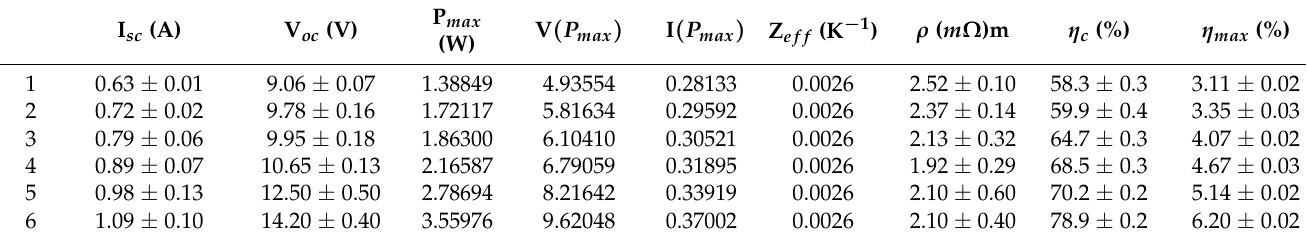
Table 3. Calculated parameters from the fitting data and model.